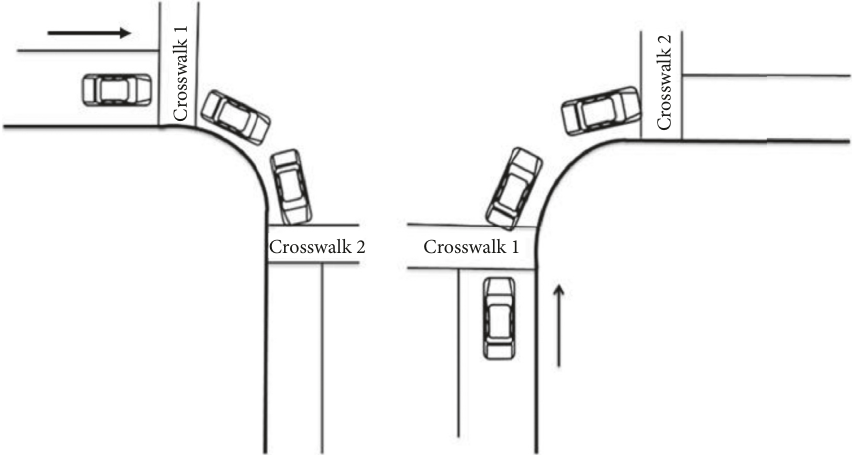
Figure 5: Location distribution of crossing.